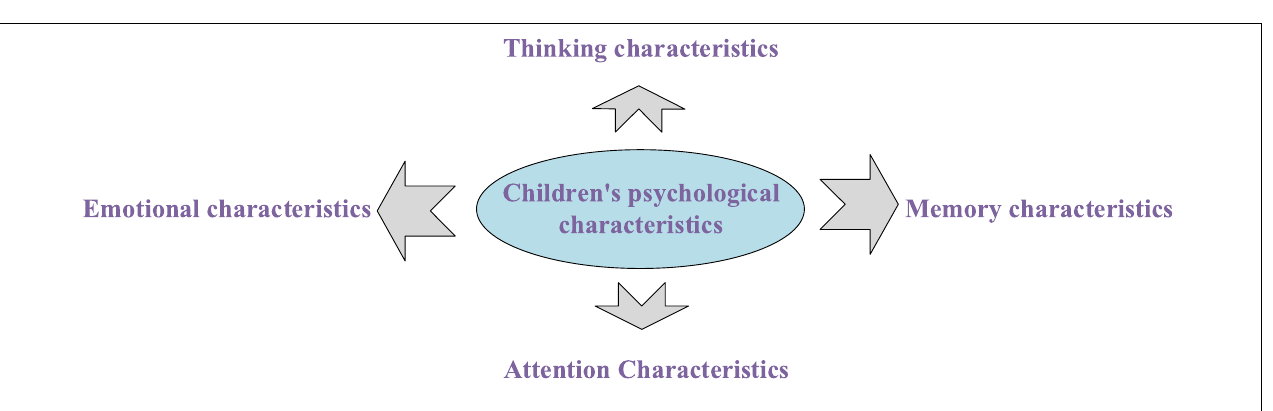
FIGURE 5 | Children’s psychological